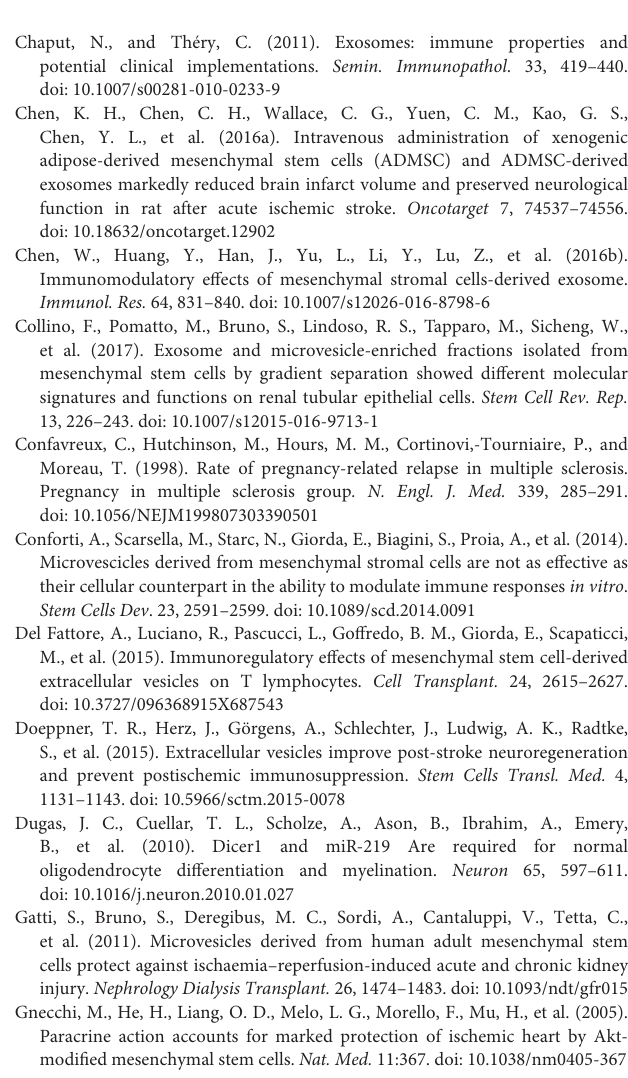
drawing Figure 1 . AR: compilation of article content, writing some